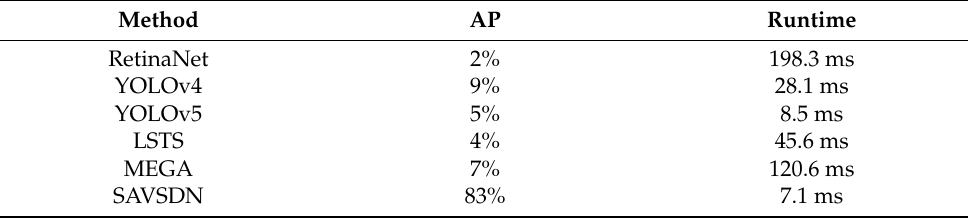
Table 2. System comparison and the corresponding performances for spark